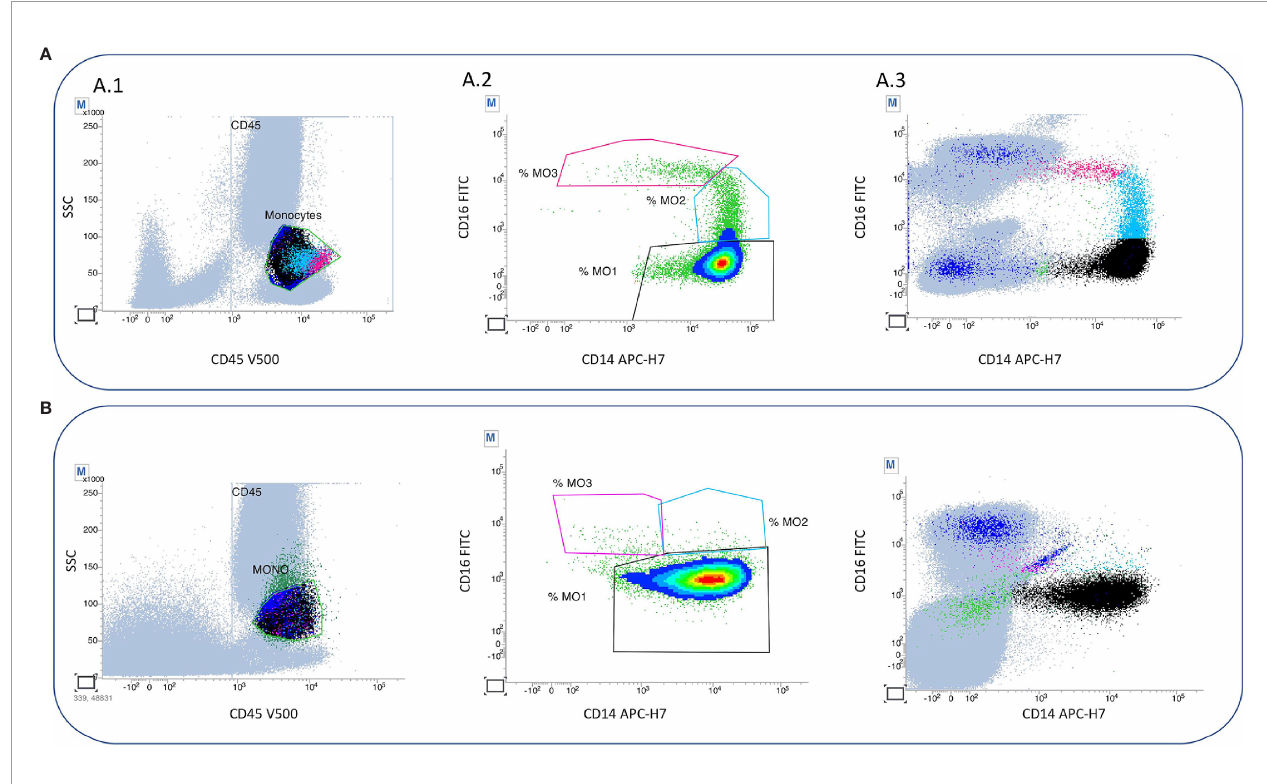
FIGURE 2 | Flow cytometry analysis of monocyte subset onperipheral blood samples of a patient with ECD. (A) Flow cytometry analysis of monocyte subset in ECD remission.A.1 Monocyte population (green)is gatedin dot plotSSC/CD45, and the zone ispuri fi ed residual population (blue) by exclusion of T and NK lymphocytes with expression of CD7, granular cellswith expression of CD16 + andCD14 + ) and B lymphocytes without CD16 - but with expression of CD24 + . A.2 The three subtypes of monocytes are gated with the combination CD16/CD14: classical monocytes are MO1 (black) CD16 − CD14 + representing 92.9% oftotal monocytes. Intermediate monocytes are MO2 (blue) CD16 + CD14 +low and represent 5.7% of total monocyte. Non-classical monocytes are MO3 (pink)expressing CD16 + without CD14 and representing 1.2% of total monocytes. A.3 In order to de fi ne the subtype, the gate ispositioned with the help of allcells. (B) Flow cytometryanalyses of monocyte subset in ECD fl are The three monocytes subsets are gated with the combination CD16/CD14: classicalmonocytes areMO1 ((black) CD16 − CD14 + representing 97.5% oftotal monocytes. Intermediate monocytes are MO2 (blue) CD16 + CD14 +low representing 0.7% oftotal monocytes. Nonclassical monocytes are MO3 (pink) CD16 + CD14 - representing 1% of total monocytes. CD45 V500 , CD7 V450 , CD16 FITC , CD24 PE , CD14 APC-H7 , andCD56 PC7 . BC, Beckman Coulter Immunotech,Miami, FL, USA; BD,BD Biosciences, San Jose, CA, USA; V500, Horizon V500; APC-H7, allophycocyanin-H7; PC7, phycoerythrin-cyanin-7; PE, phycoerythrin;V450, Horizon V450; FITC, fl uorescein isothiocyanate. Peripheral bloodmononuclear cells (PBMC) were stained with CD15, CD 14, CD13 PE-CF594, CD33, CD34, andCD45 KO, and monocytes subsets were sorted. PBMC were centrifugatedona microscopeslide, dried at room temperature for 30 min,and stained usingMay – Gruenwald – Giemsa stain. Monocyte population isgatedin dot plotSSC/CD45, and the zone ispuri fi ed of residual population byexclusion of T andNKlymphocytes with expression of CD7, granular cells with expression of CD16 + and CD14 + andB lymphocytes without CD16 − but with expression ofCD24 +